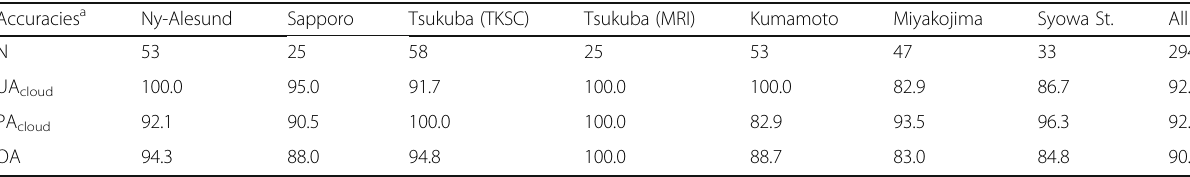
Table 9 Summary of cloud detection accuracies Accuracies